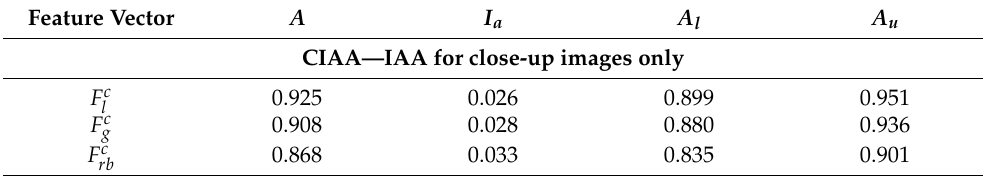
Table 11. Evaluations of CIAA using global features, RB features and both global features and RB